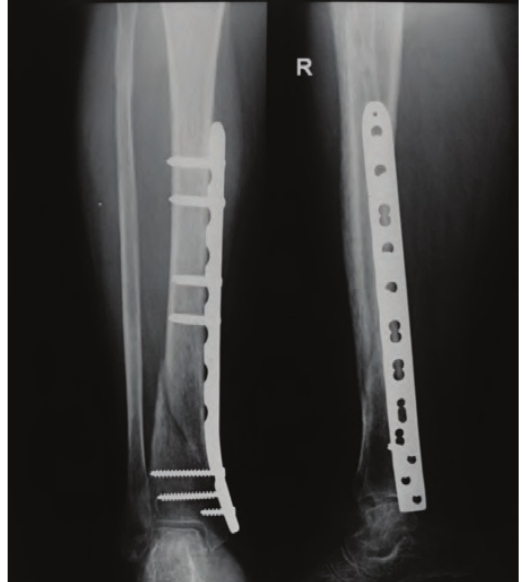
Figure 4: POD 1 Immediate post operative x-ray after MIPO